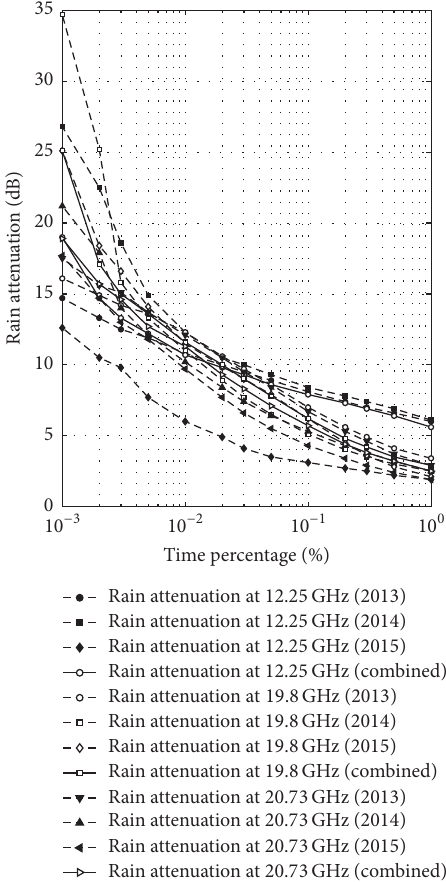
Figure 3: Distribution of rain attenuation at Mokdong